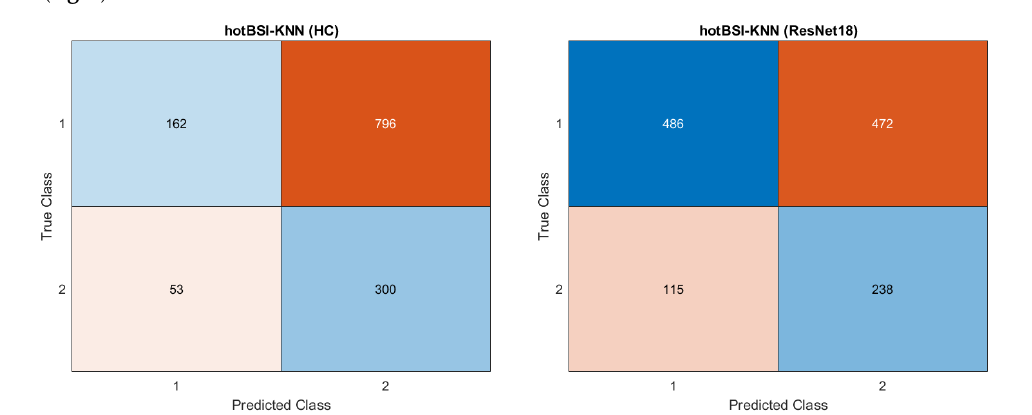
Figure A2. Confusion matrices for the hotBSI-SVM trained with handcrafted ( left ) and ResNet18 ( right ) features.